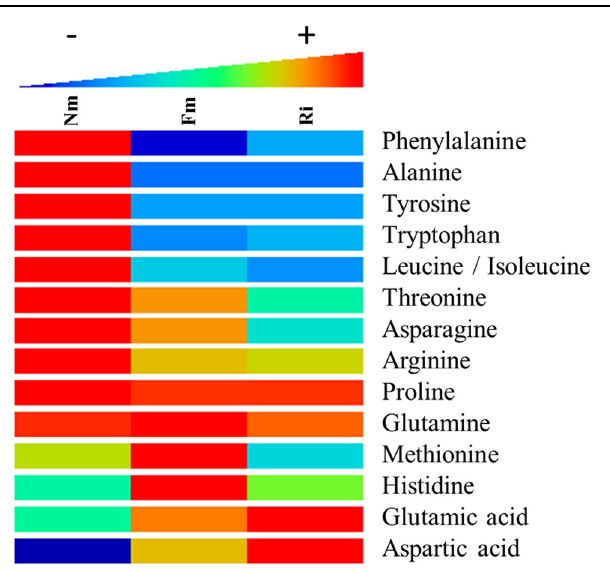
FIGURE 3 | Heat map analysis of amino acid content in non- mycorrhizal (Nm), F. mosseae -colonized (Fm) and R. irregularis - colonized roots (Ri). Samples for analysis were collected 8 weeks after fungal inoculation. Data points represent six biological replicates injected randomly into the HPLC–QTOF MS. Color scale represents the variation in the accumulation of the amino acids, from high (red) to low (blue) contents. Signals corresponding to different treatments were compared using the non-parametric Kruskal–Wallis test, only data with a p < 0.1 (between groups) were used for a supervised analysis. Values are relative to the sample dry weight and normalized to the lowest